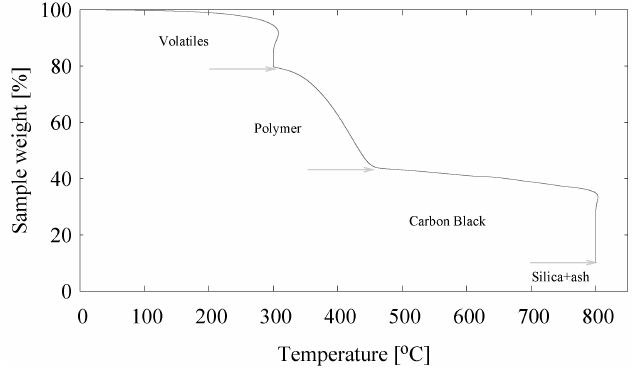
Figure 2. TGA analysis of the